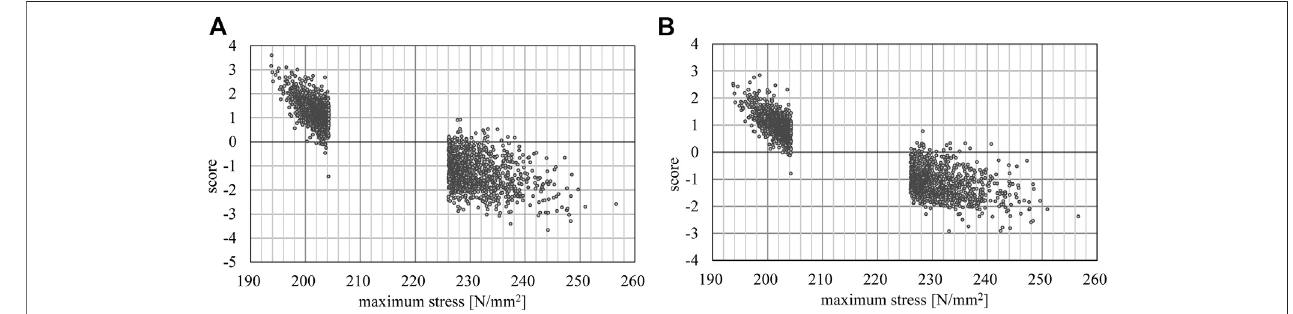
FIGURE 6 | Relation between maximum stress of the 24-story frame and the score; (A) linear kernel, (B) RBF kernel.